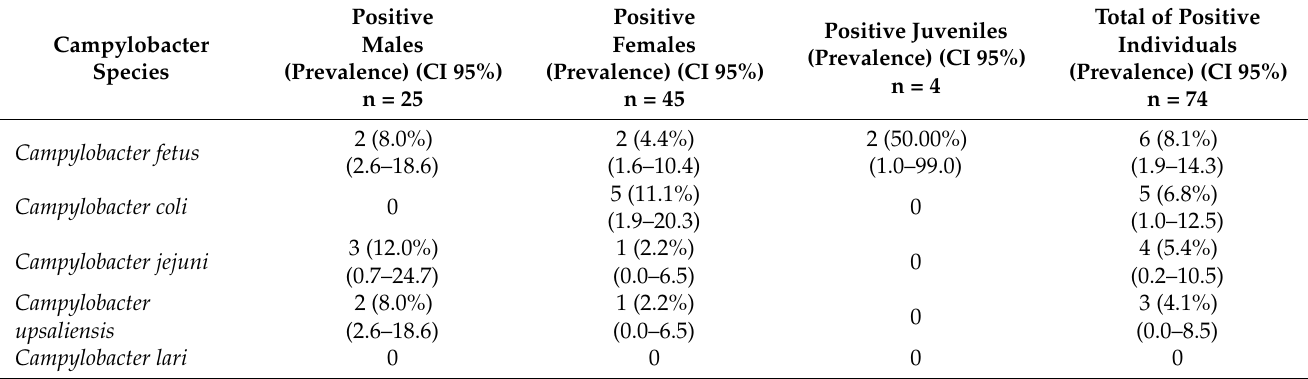
Table 2. Prevalence of Campylobacter sp. detected in Anolis sp. from Tenerife, Canary